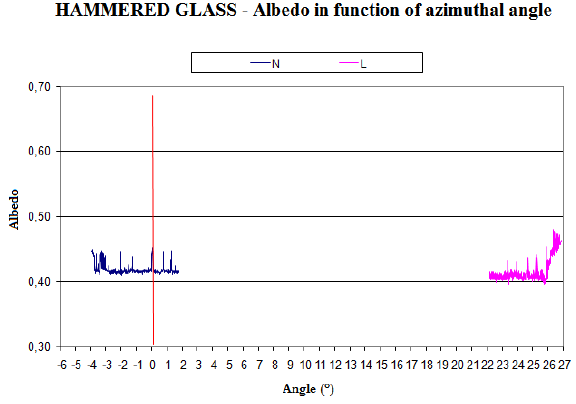
Figure 6 - Albedo whit azimuth range of 10 °, left shooting